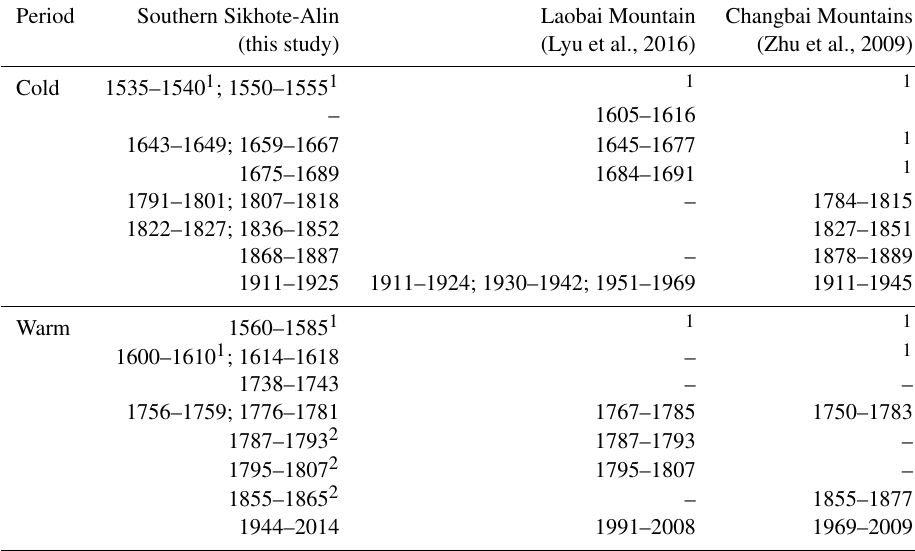
Table 3. Cold and warm periods based on the results of this study compared with other research.